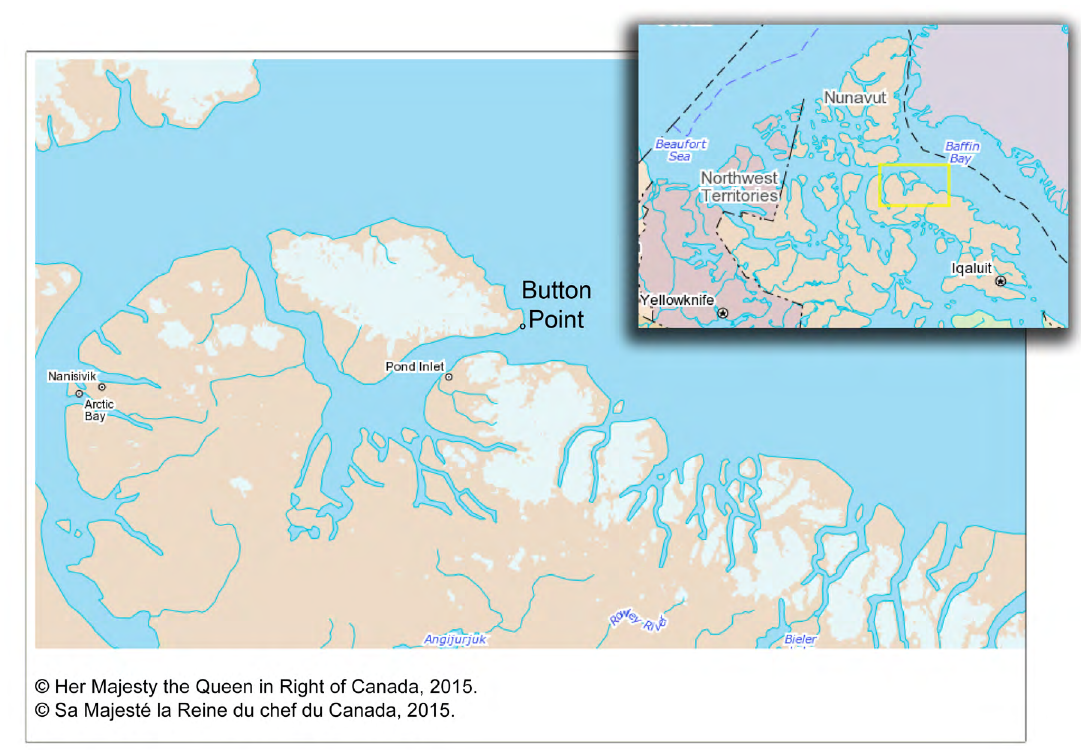
Figure 1. Location of Button Point on Bylot Island,